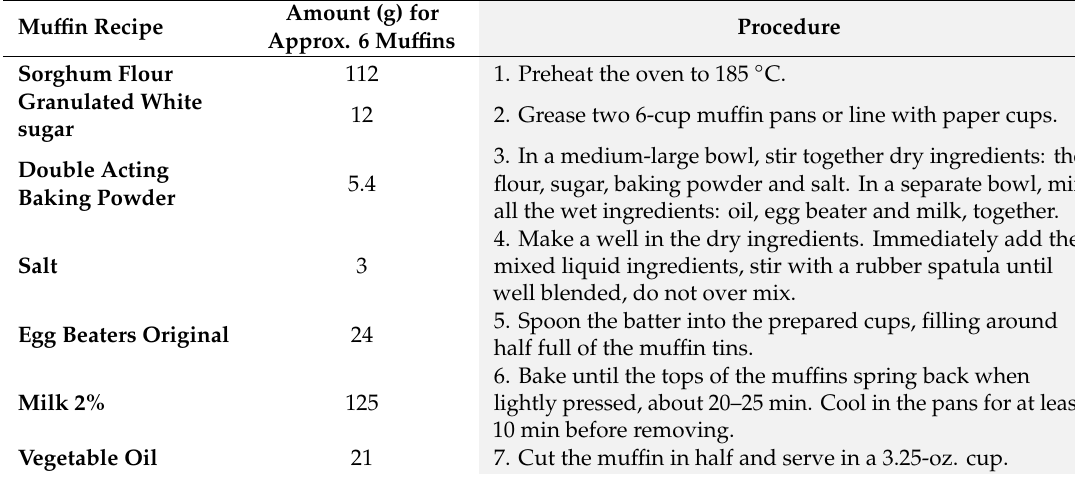
Table 4. Mu ffi n’s recipe and baking